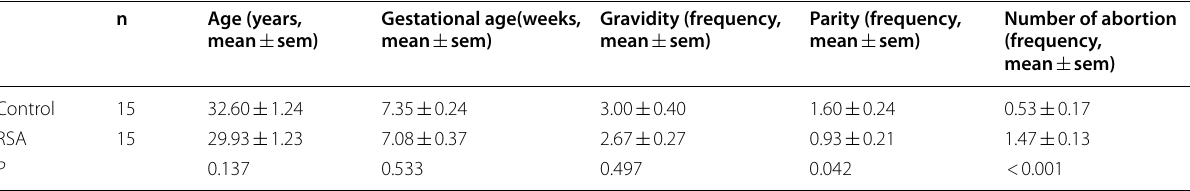
RSA recurrent spontaneous abortion, sem standard error of the